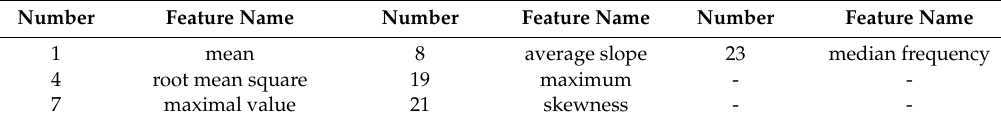
Figure 5. Feature classification weight diagram after threshold setting. ( a ) Upper submap: Feature weight value map; ( b ) Lower submap: Weight value frequency chart. In this paper, the mainstream feature selection method least absolute shrinkage and selection operator (LASSO) and principal component analysis (PCA) are compared horizontally. The classification effect of (LASSO) is shown in Figure 6. The classification accuracy is shown in Table 4.